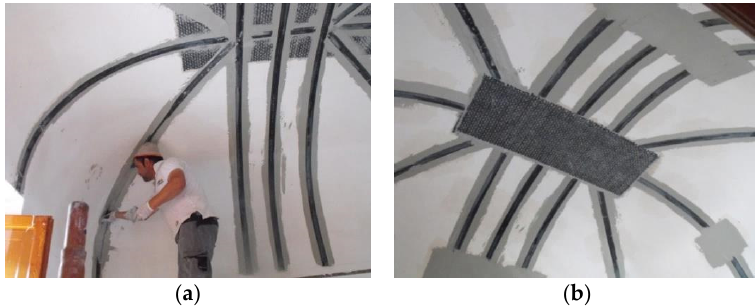
Figure 5. Reinforcement application: ( a ) CFRP strips; ( b ) CFRP sheet at vault crown.